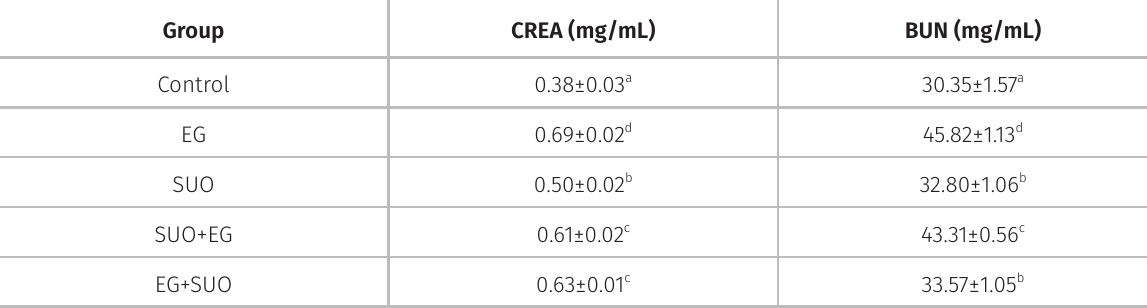
Table III. Serum Creatinine (CREA), Blood Urea Nitrogen (BUN)